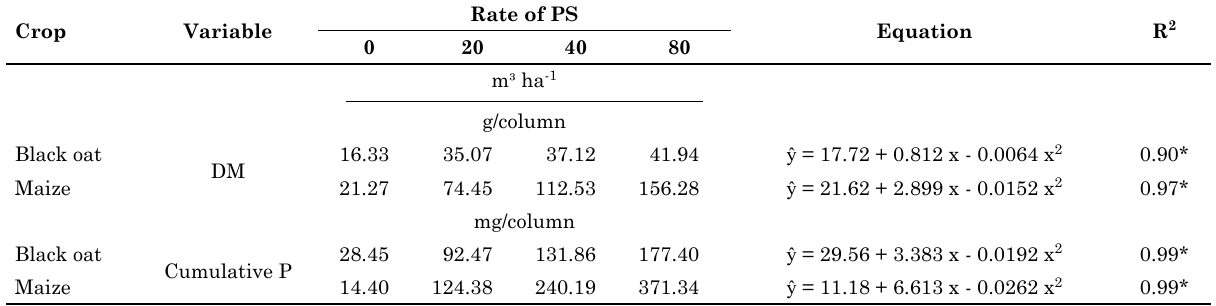
table 3. Production of dry matter (dm) and cumulative P in shoot oat and maize grown in a typic hapludalf soil treated with 0, 20, 40, and 80 m 3 ha -1 of pig slurry (Ps)